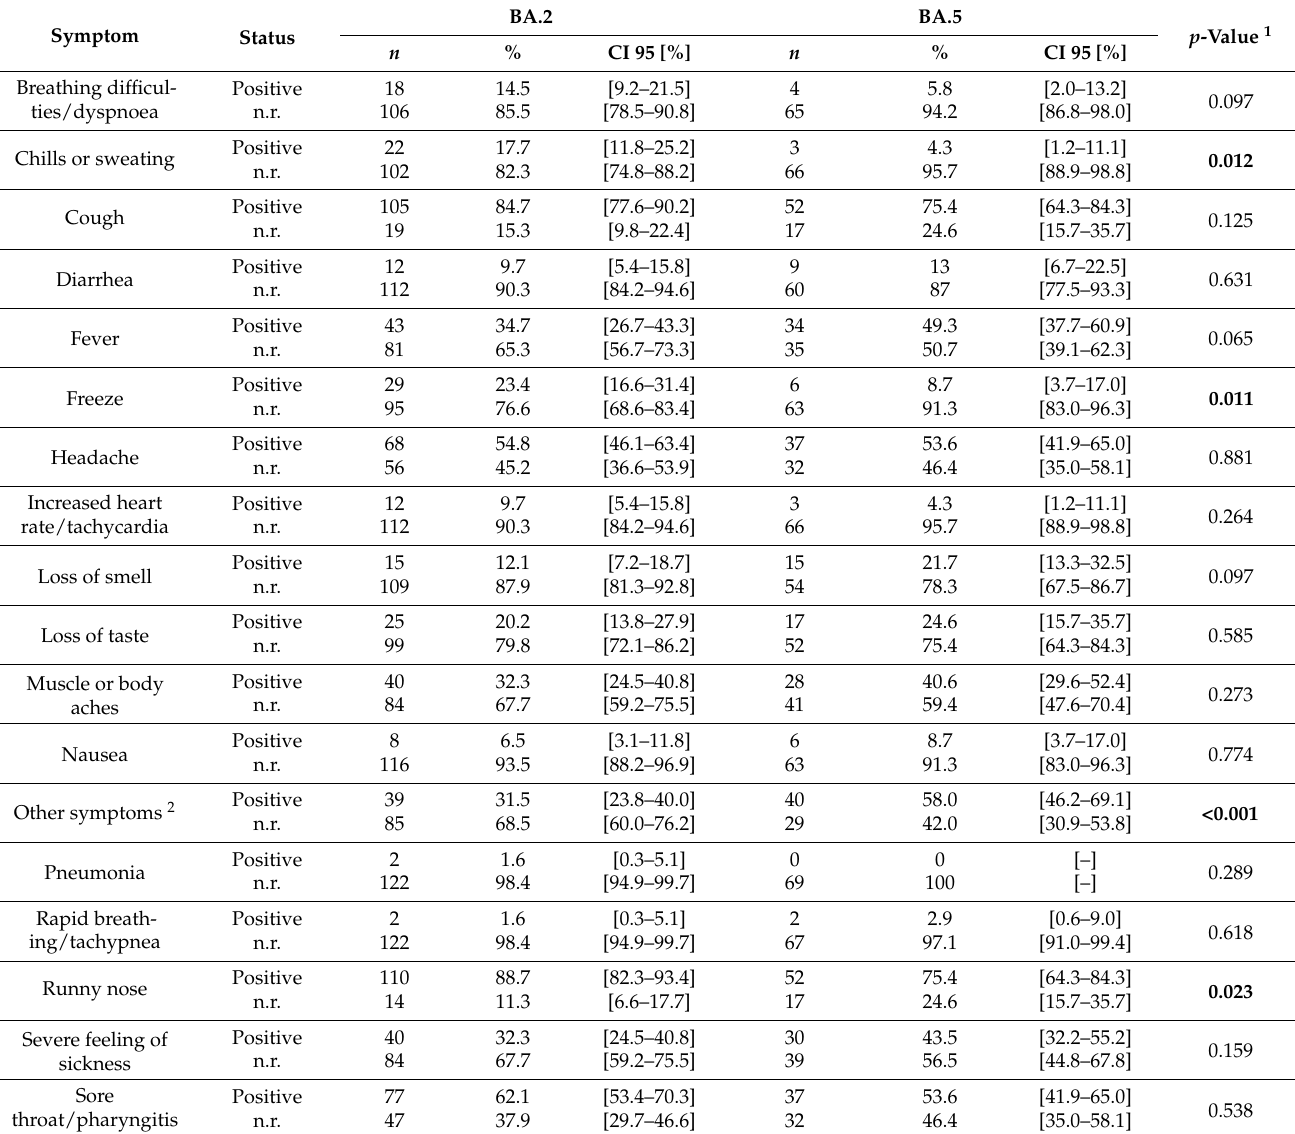
Table 2. Differences between reported symptoms from symptomatic BA.2 and BA.5 cases (CI, confidence interval (CI 95% [lower–upper]); Positive, positively reported; n.r., not